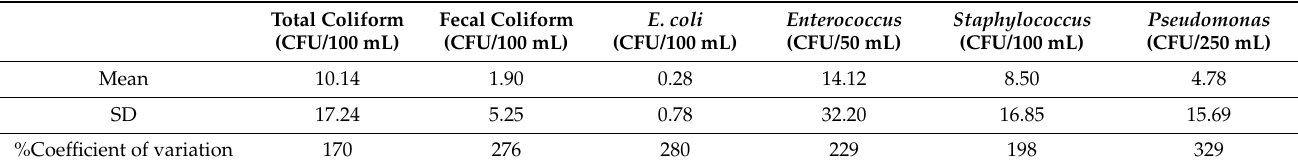
Table 4. Descriptive statistics of the enumerated bacterial